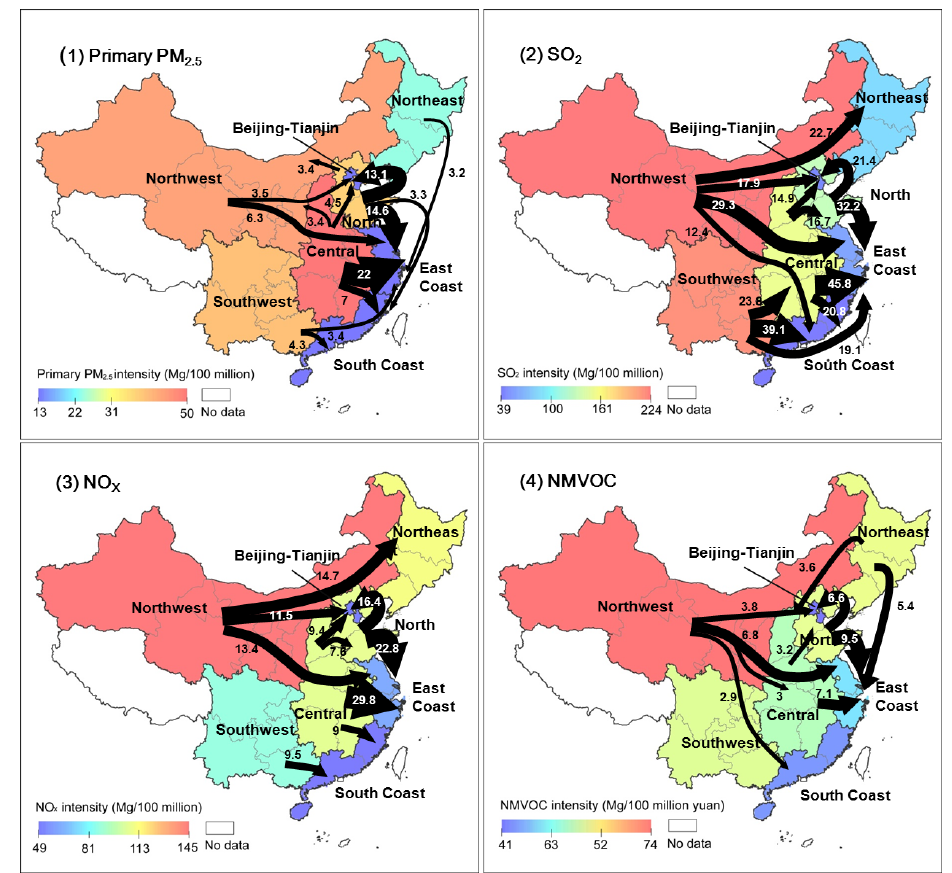
Figure 4. Largest net flows of primary PM 2 . 5 , SO 2 , NO x and NMVOC emissions embodied in interprovincial trade in 2007 (unit of flow: Gg). The shading in each region indicates the related production emission